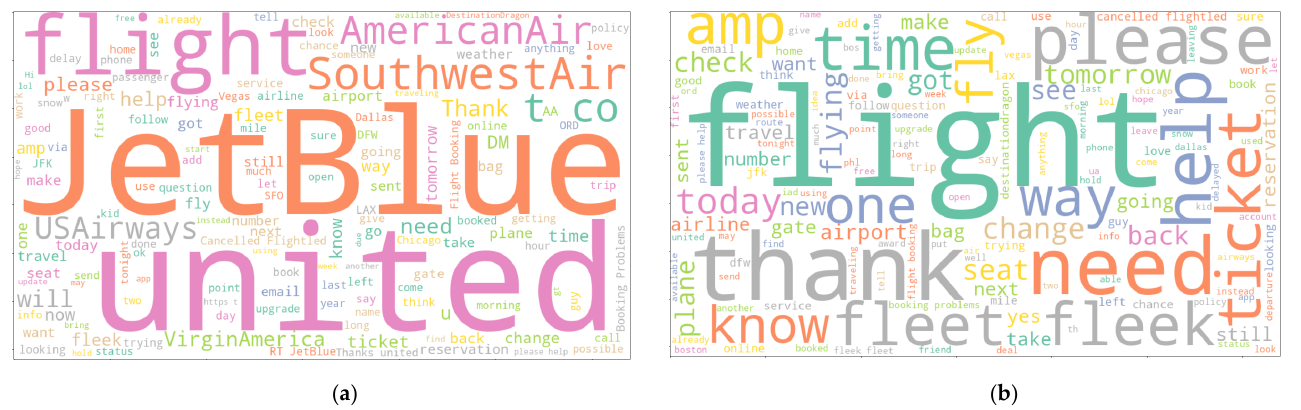
Figure 8. ( a ) Word Cloud of neutral tweets—before preprocessing and ( b ) Word Cloud of neutral tweets—after preprocessing.